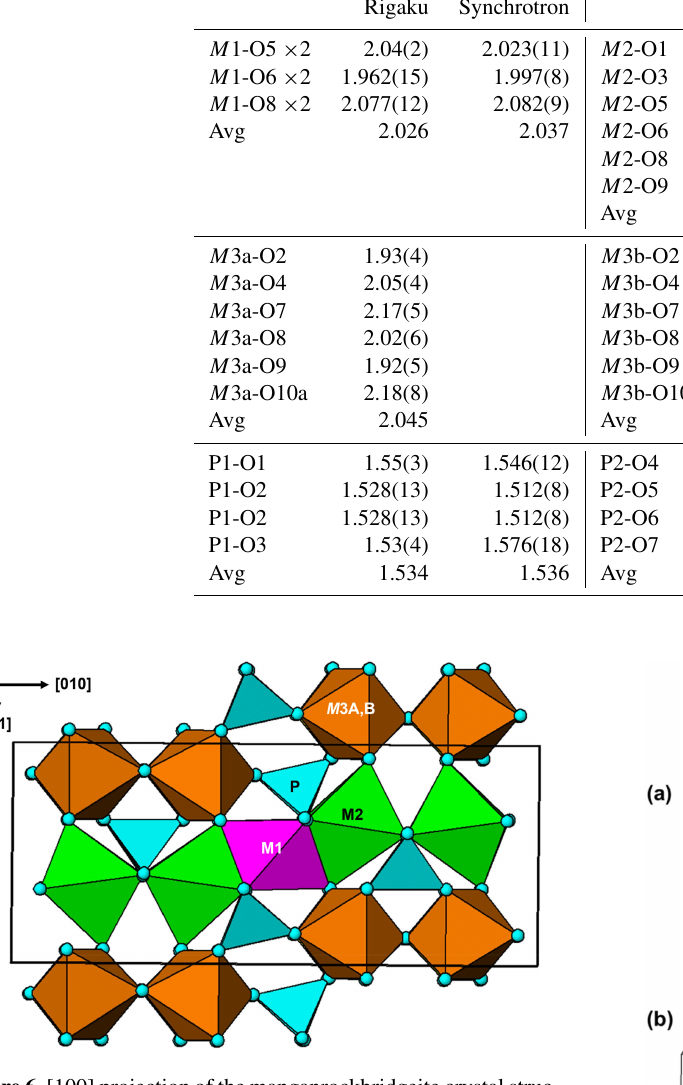
Figure 6. [100] projection of the manganrockbridgeite crystal struc- ture.